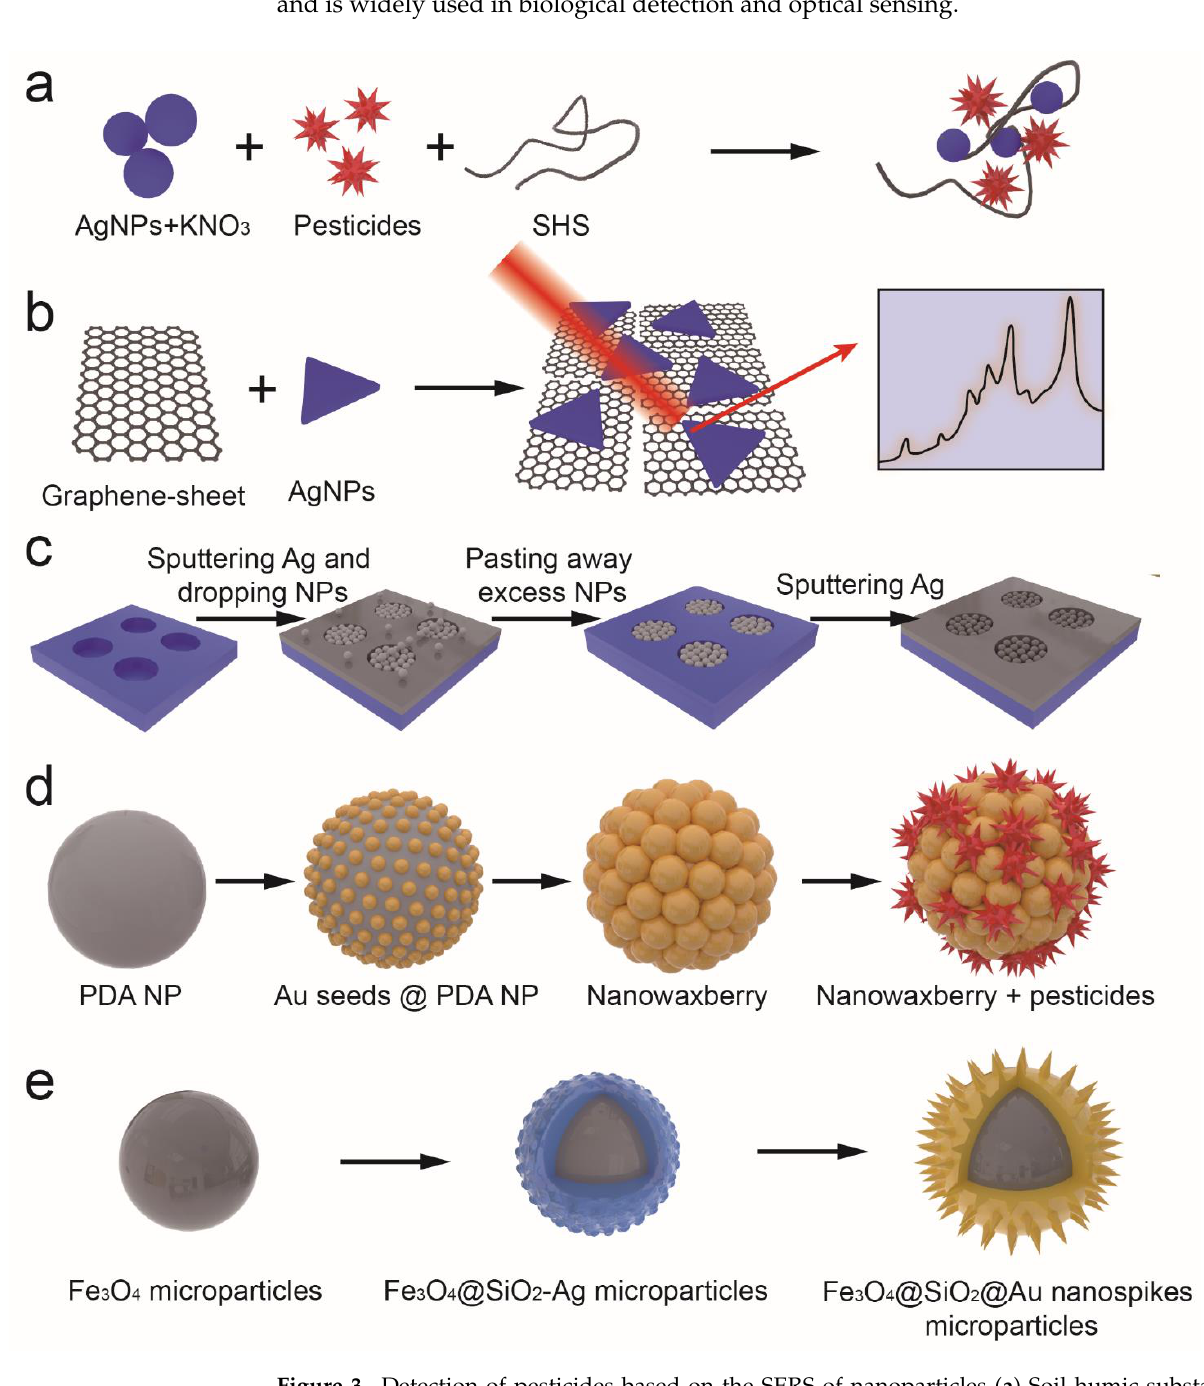
Figure 3. Detection of pesticides based on the SERS of nanoparticles ( a ) Soil humic substances-assisted AgNPs SERS substrates for the detection of s-triazine pesticides [27]. ( b ) Preparation of Ag-nanoplate decorated graphene-sheet SERS substrates for the detection of organic pesticides [29]. ( c ) Magnetic assembled 3D SERS substrate for sensitive detection of pesticide residue in soil [30]. ( d ) Polydopamine gold nanowaxberry-based SERS substrate for detection of pesticides [32]. ( e ) Dense Au nanospikes grown on magnetic microparticles for the detection of pesticides [34].